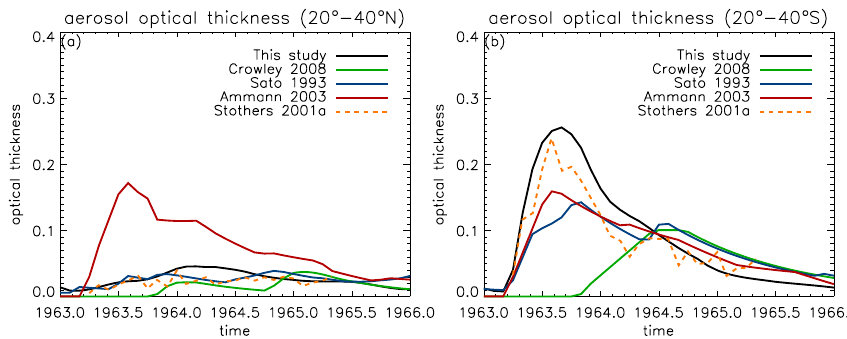
Fig. 13. Zonal mean total optical depth (AOD) in VIS (550nm) for the Agung 1963 eruption for (a) 20 ◦ N–40 ◦ N and (b) 20 ◦ S–40 ◦ S. Comparison to observations compiled in Stothers 2001.